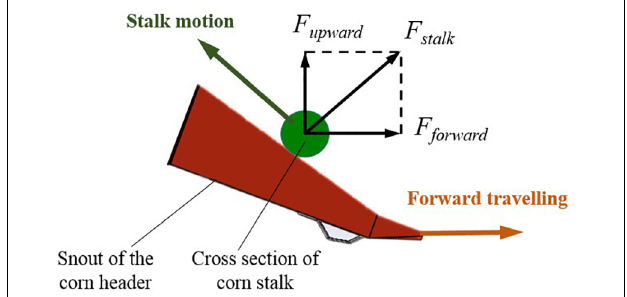
FIGURE 12 | Forces on the lateral lodged corn stalks in the